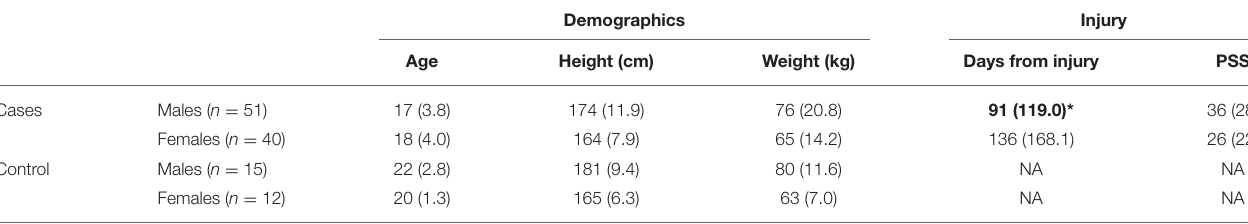
TABLE 2 | Patient characteristics.